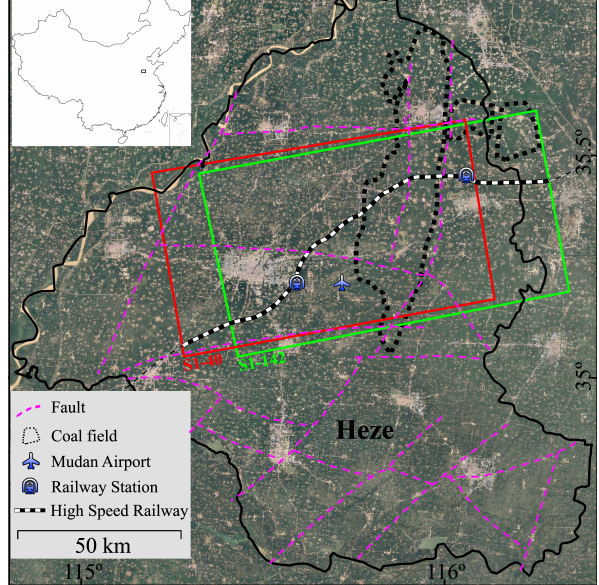
Figure 1. Study area and outline of Sentinel-1 acquisitions super- imposed on a Google Earth optical image (© Google Maps). Black polygon represents the boundary of the Heze region.